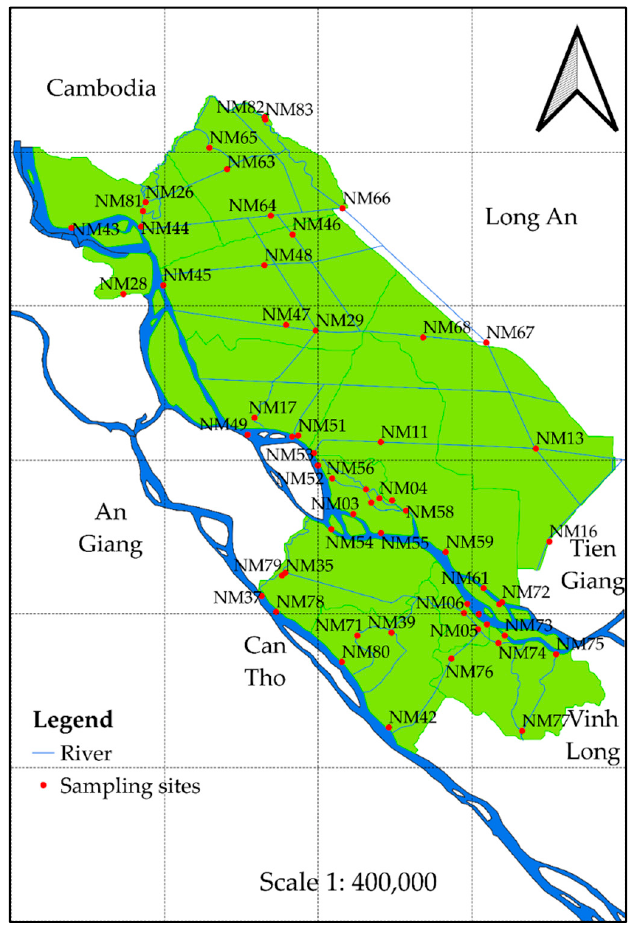
Figure 1. Demonstration of the water sampling sites in Dong Thap province in 2019.